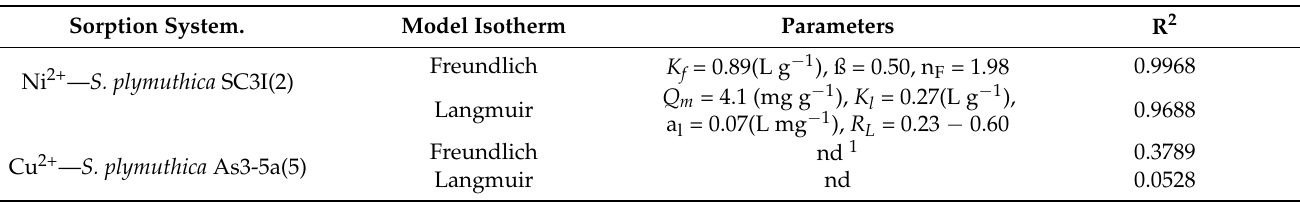
Table 1. Summary of the Freundlich and Langmuir isotherm constants and comparison of linear regression coefficients of determination.